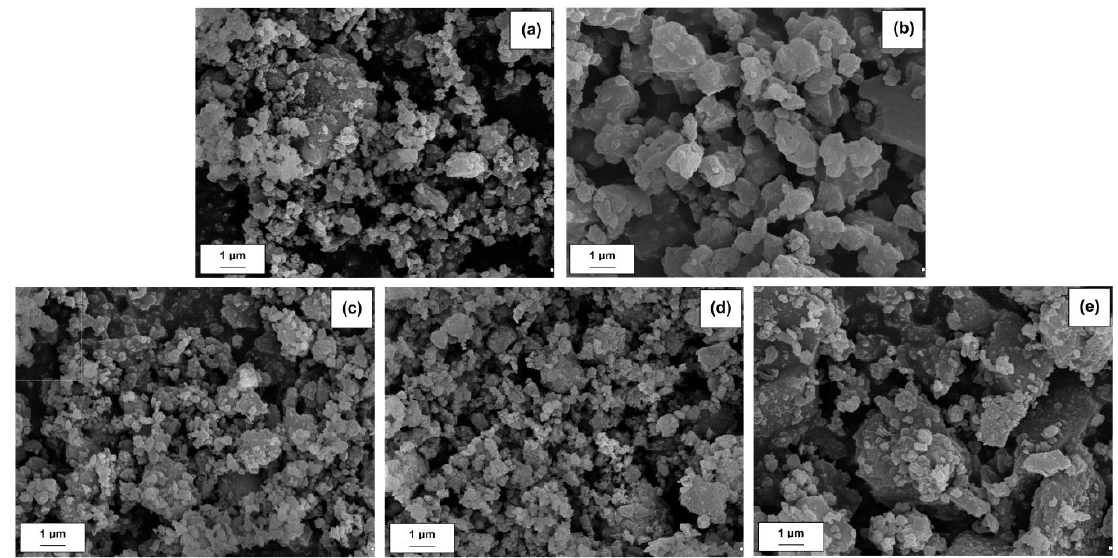
Figure 2. SEM images of MgO ( a ), lignin ( b ) and MgO-lignin hybrid materials with a weight ratio of components equal to: 5:1 w / w ( c ), 1:1 w / w ( d ), and 1:5 w / w ( e ).